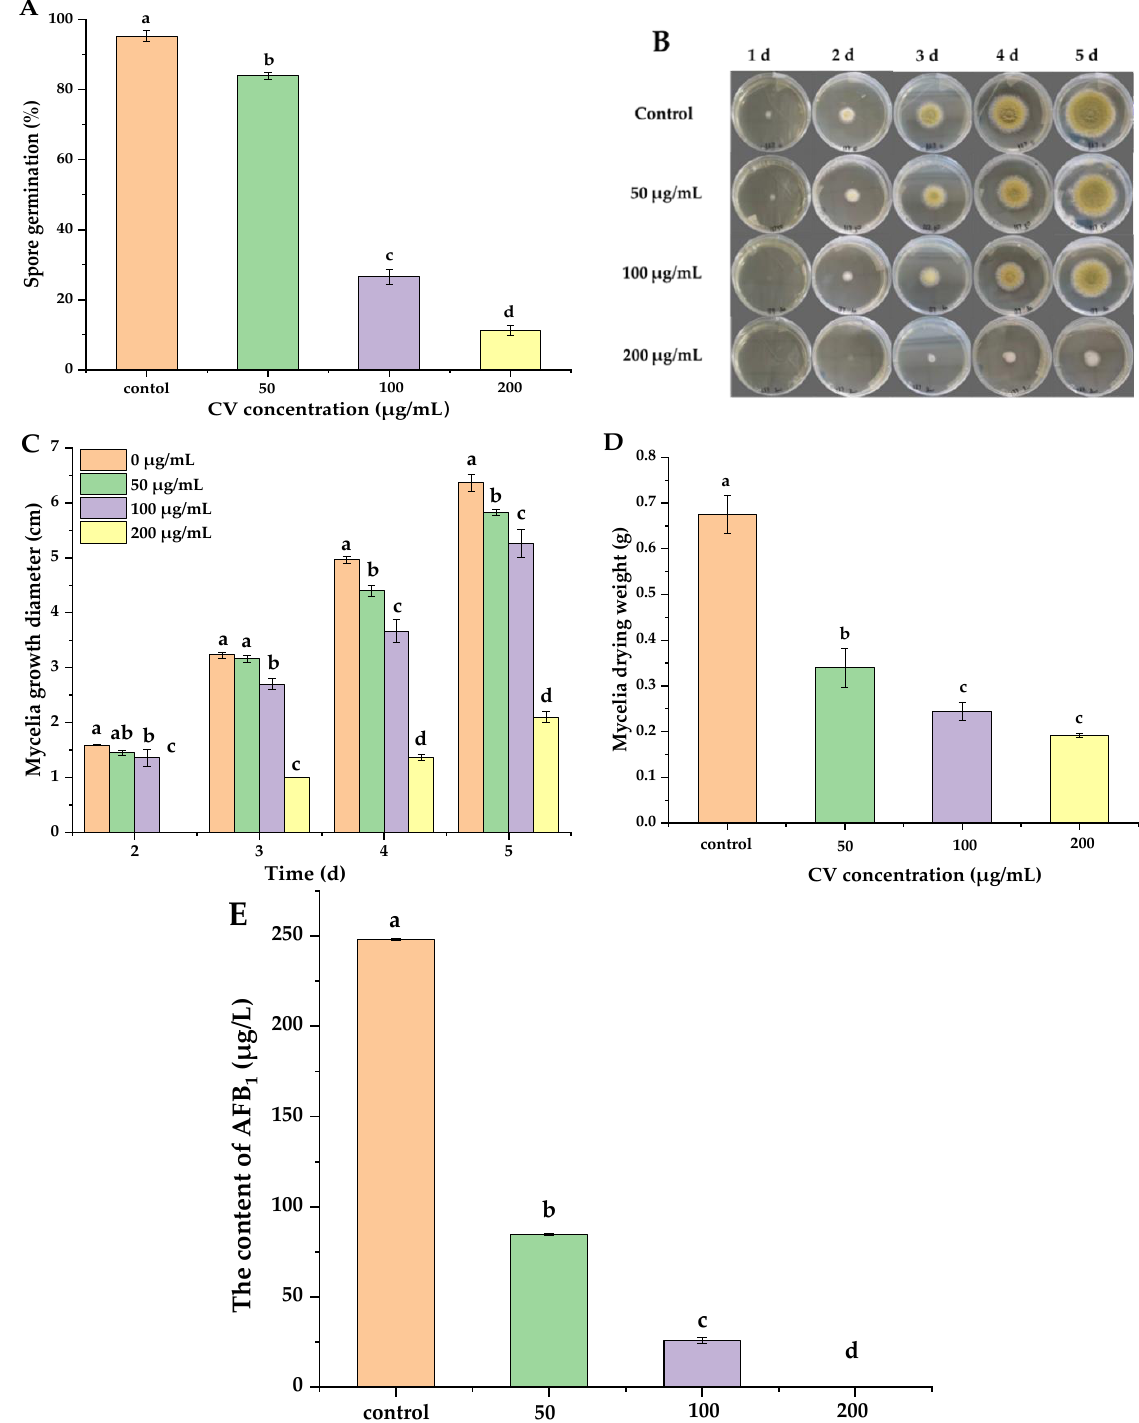
Figure 1. Antifungal activity of CV on A. flavus . ( A ) Spore germination, ( B , C ) colony growth diameter, ( D ) mycelia weight and ( E ) the content of AFB 1 . Different letters indicated significant differences ( p < 0.05).